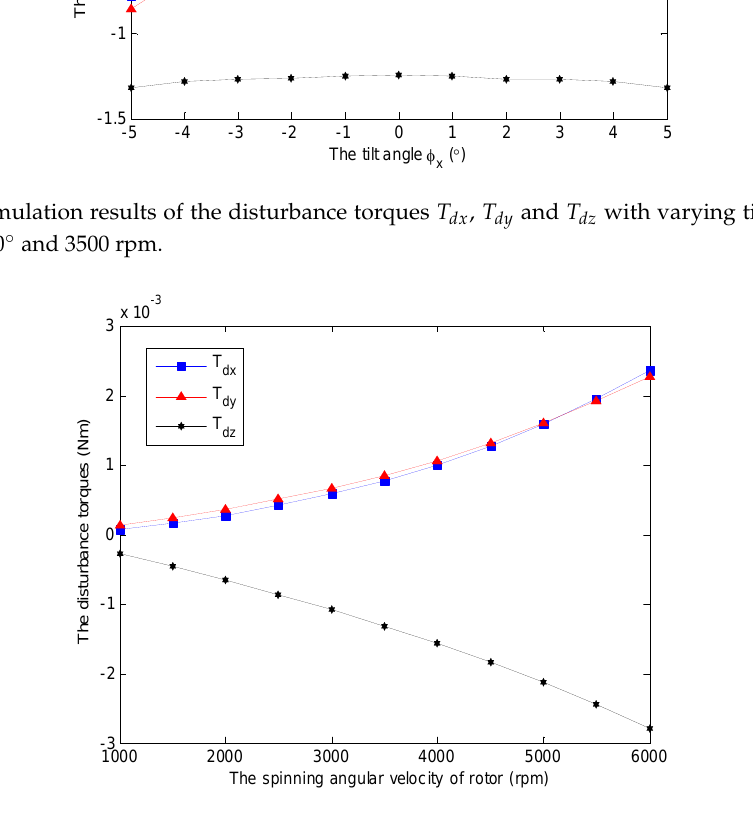
Figure 9. Simulation results of the disturbance torques T dx , T dy and T dz with varying angular velocities under φ x = 5 ◦ and φ y = 0 ◦